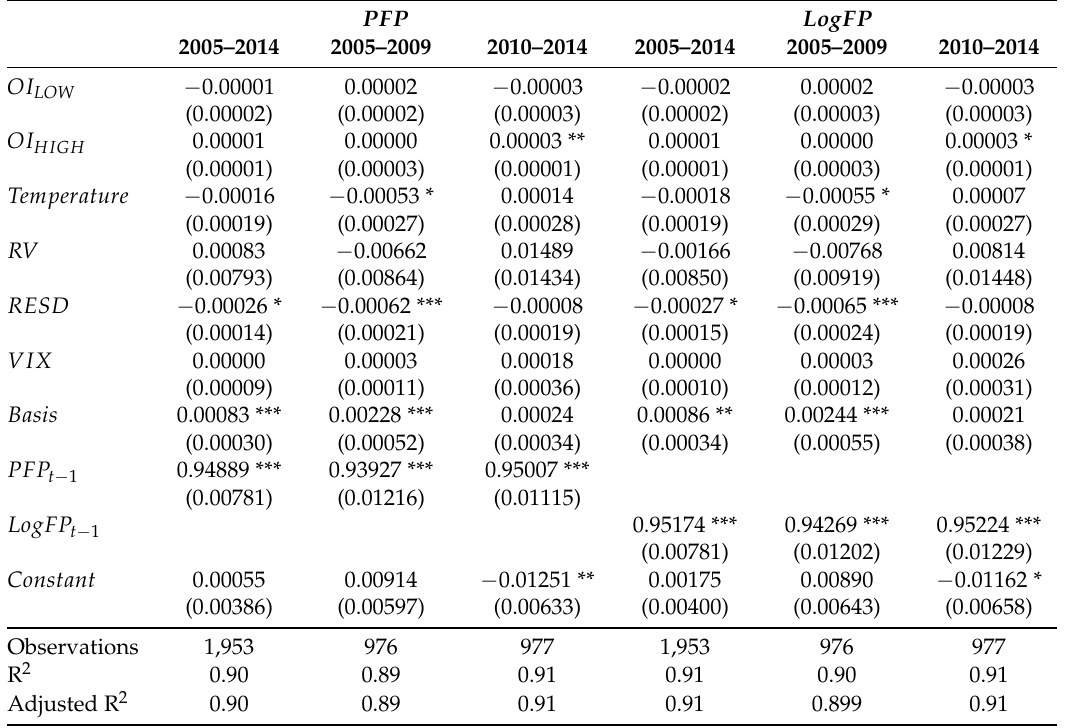
Table 3. Results from the OLS regression. Heteroskedasticity-consistent standard errors are shown in brackets. ***, ** and * indicate significance at the 1%, 5% and 10%